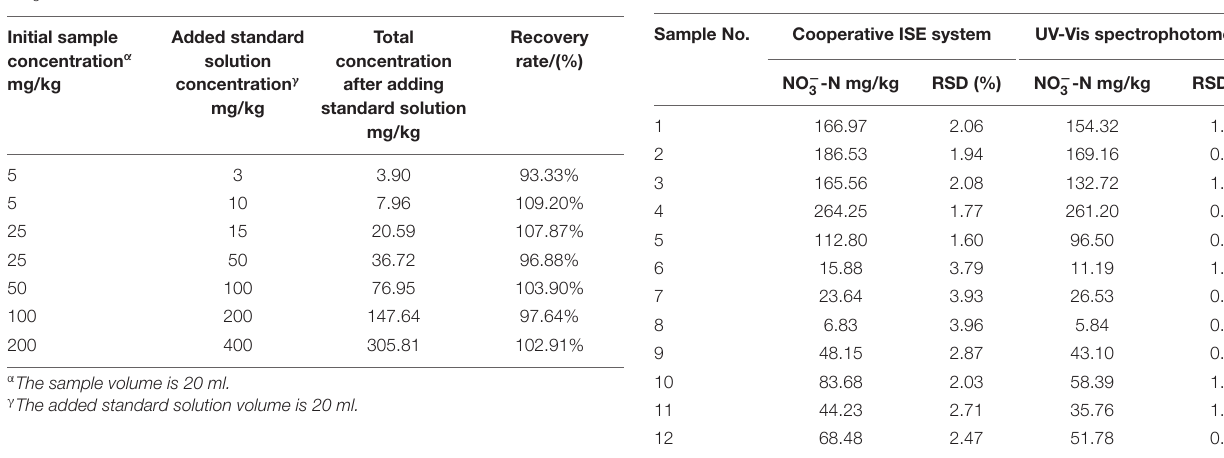
TABLE 2 | Recovery rate of the ion-selective electrode (ISE) system on detecting NO − 3 -N.